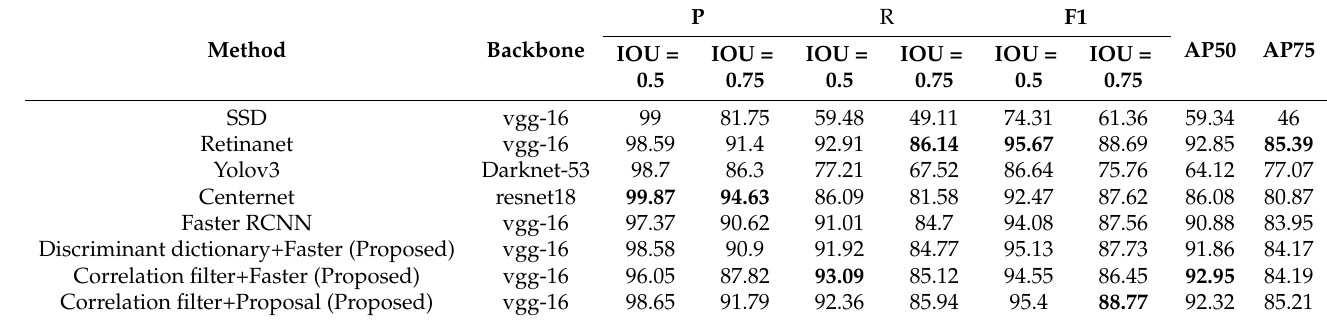
Table 1. Test results between the proposed method and the state-of-the-art methods (%).